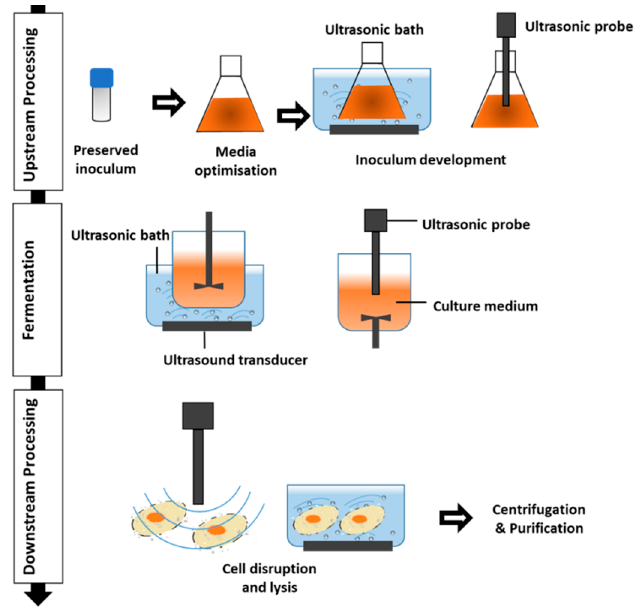
Figure 1. Application of ultrasound in different stages of microbial metabolite processing.